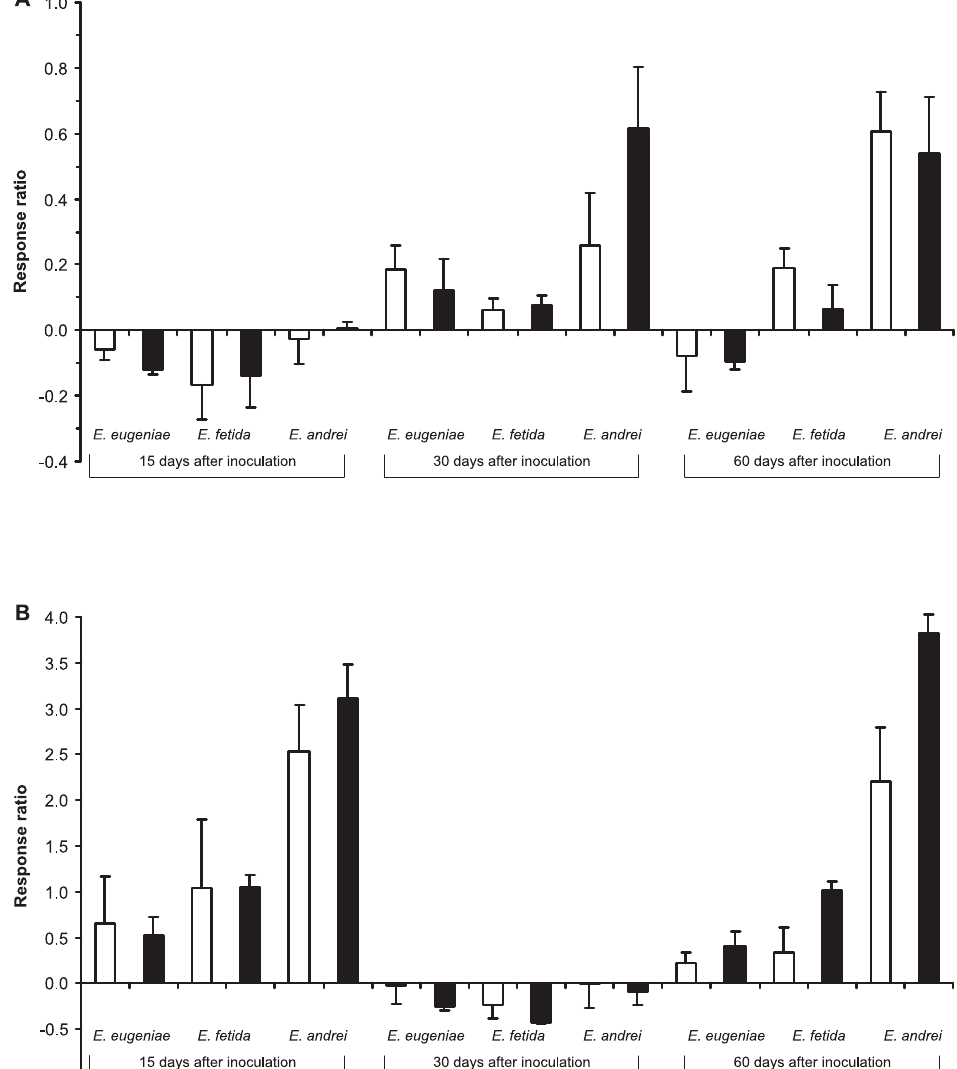
Figure 2. Effects of type of vermicompost, dose of inoculation and time on C metabolism. Shown are the changes in the a) b -glucosidase activity and b) cellulase activity in presence of inoculum of vermicompost (2.5 and 10%) relative to control (no inoculum) calculated as (V i -V c )/V c , where V i and V c are the values of the variables of samples inoculated with vermicompost or controls. White and black bars represent 2.5 and 10% of inoculation respectively. Mean 6 SE